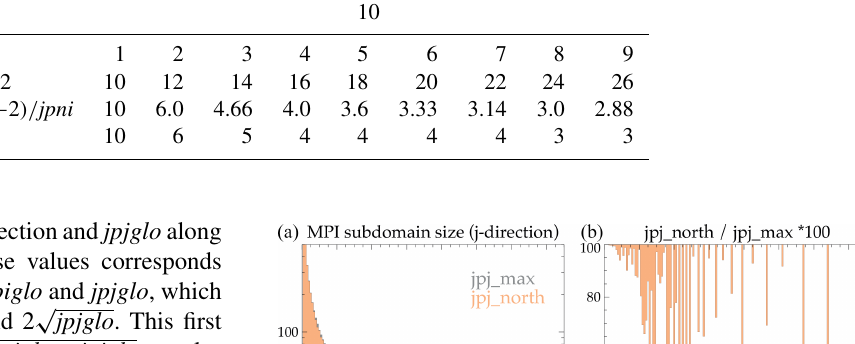
Table 1. Example of 1D 10-point domain decomposition. jpiglo